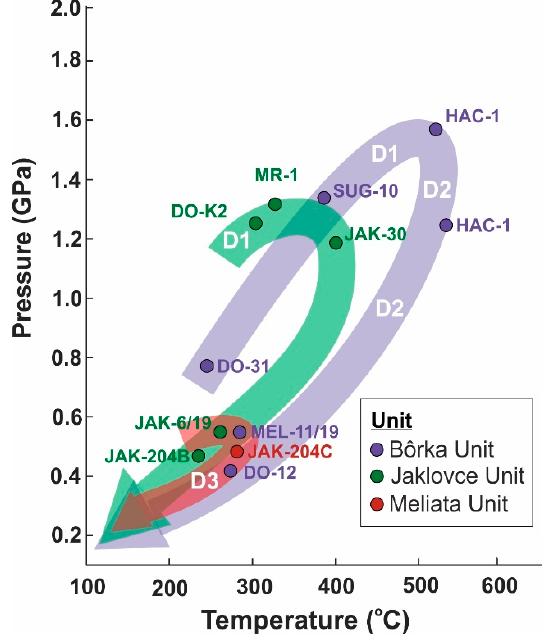
Figure 34. Estimated P–T paths from Meliatic Superunit. Review of P–T data in Table 14.